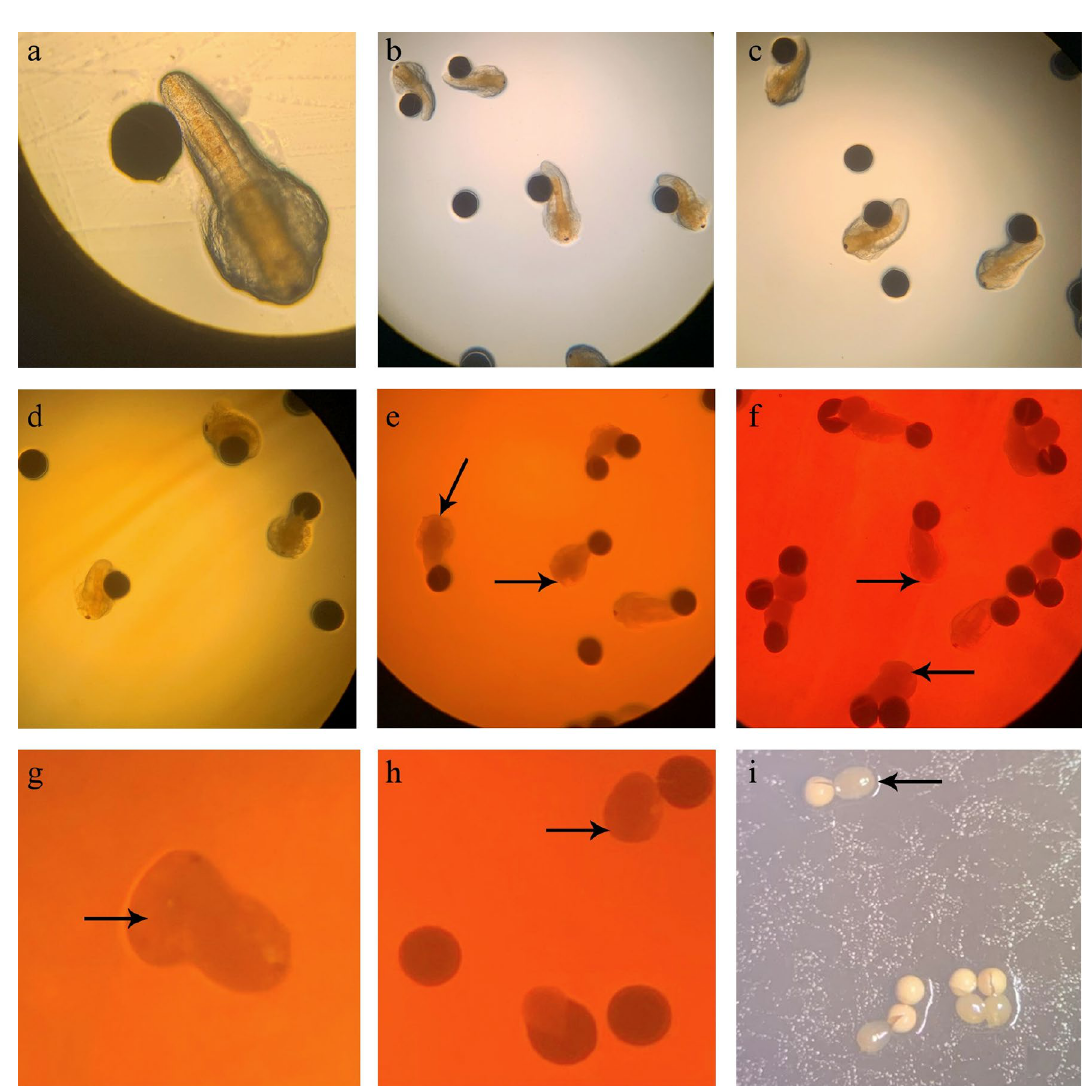
Figure 7. Morphology of Artermia in (a) control samples, (b) 30 mgL −1 , (c) 50 mgL −1 , (d) 100 mgL −1 , (e) 500 mgL −1 , (f) 1000 mgL −1 , (g) 2000 mgL −1 , (h) 3000 mgL −1 and (i) 5000 mgL −1 after 48 h of AgNP exposure. The arrows show the absence of eyes in samples (e–f)